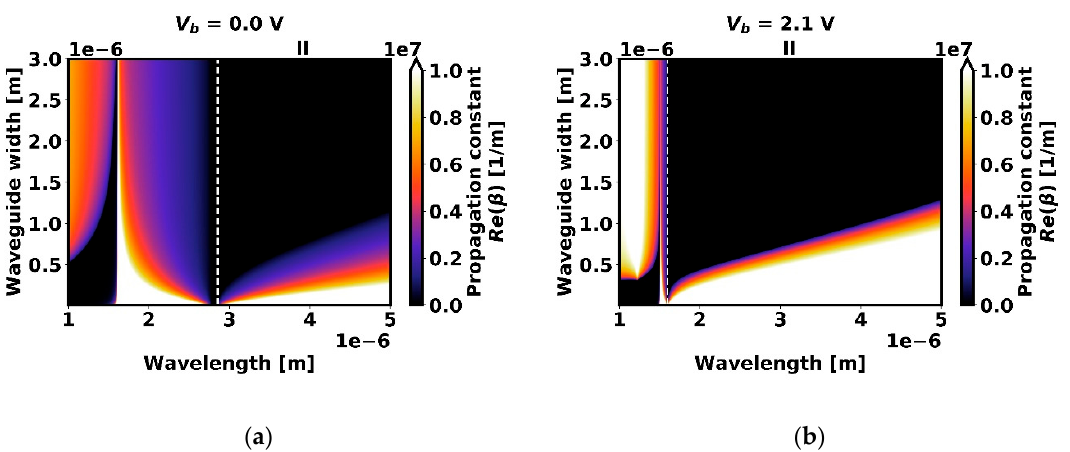
Figure 8. Map of propagation constant values for TM1 for a configuration B at various bias voltages: ( a ) 0 V and ( b ) 2.1 V. Type II HMM is indicated. Black areas indicate regions where propagation is prohibited.